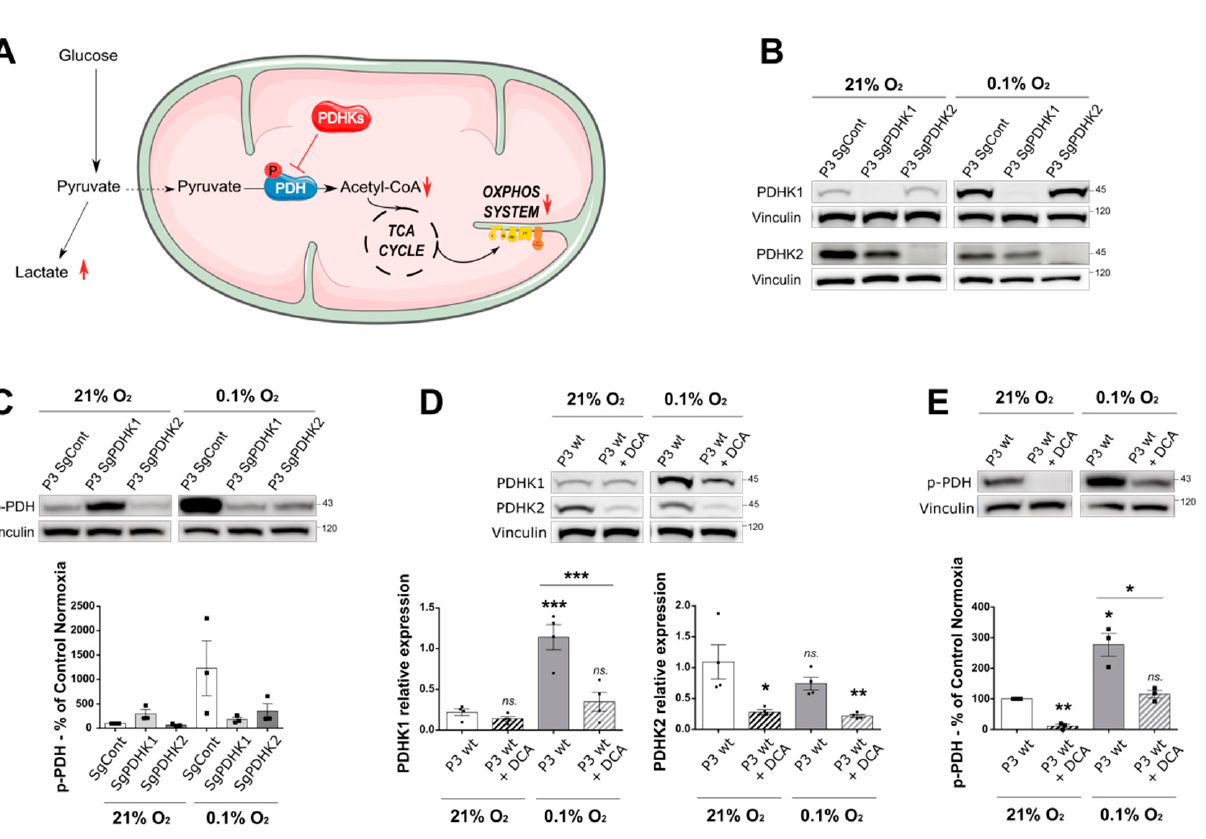
Figure 2. Dichloroacetate (DCA) reduces levels of phosphorylated PDH in a primary glioblastoma in vitro cell model, impacting cell and mitochondrial organization. ( A ) Illustration of the two alter- native pyruvate utilization pathways and the impact of PDHK activity on the balance between lactic fermentation or mitochondrial oxidation of pyruvate. ( B – E ) Western blotting and corresponding quantification of PDHK1, PDHK2 expression or phospho-PDH status in P3 cells control, knockout for PDHK1, PDHK2 or treated with DCA 25 mM for 3 days; all cells were exposed to either 21% O 2 or 0.1% O 2 . Graphs represent densitometry quantification normalized with vinculin ( n = 3 or 4). ( F ) Epifluorescence images of immunofluorescence stainings on P3 SgCont, SgPDHK1, SgPDHK2 or treated with DCA 25 mM for 3 days (Phalloidin, red; Tom20, green; Hoechst, blue). Scale bar: 20 µm. ( G , H ) Immunofluorescence image analysis (120 to 240 cells per group): ( G ) cell surface quanti- fication; ( H , left ) cell aspect ratio corresponding to the ratio of the major axis to minor axis of the